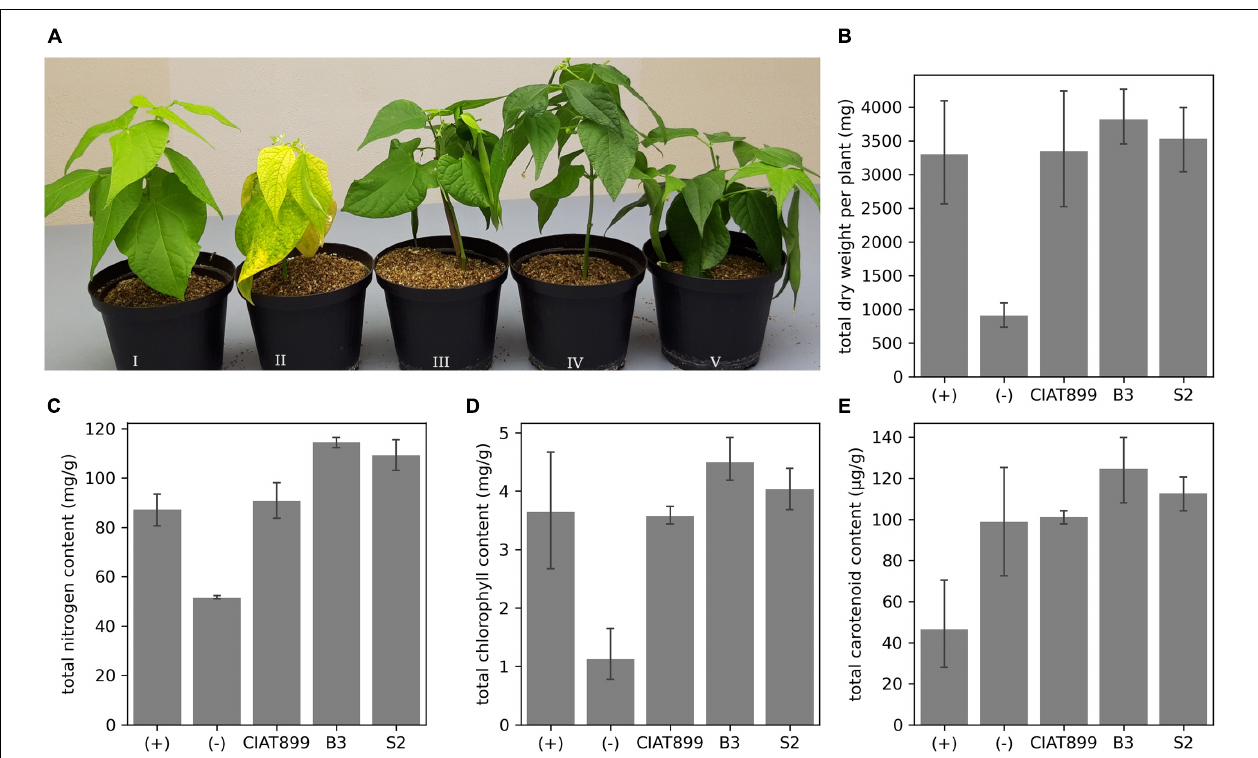
FIGURE 1 | (A) The effect of rhizobia inoculation on common bean grown under nitrogen-limited conditions in the greenhouse. Plants supplied with (I) nitrogen fertilizer; (II) no nitrogen fertilizer and no rhizobia; no nitrogen fertilizer but inoculation with CIAT899 (III), B3 (IV), or S2 (V). The (B) total dry weight, (C) the total quantity of tissue nitrogen, (D) chlorophyll, and (E) carotenoid content.